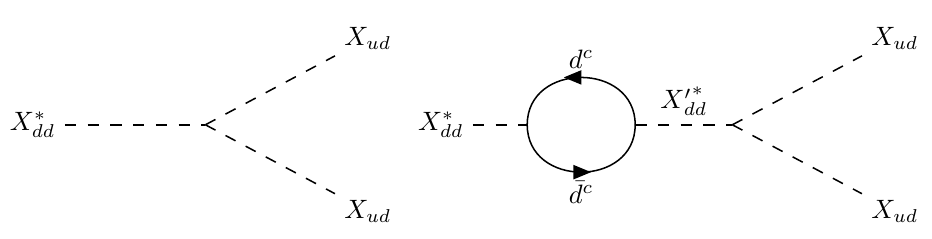
Figure 5 . Tree-level and one-loop diagrams leading to a baryon asymmetry via X dd decays.